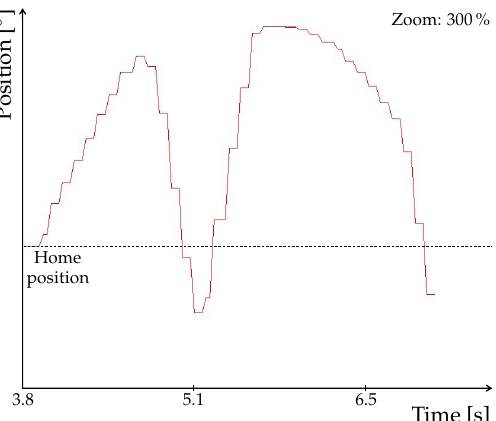
Figure 13. Detail of the signal obtained using PLC OPC UA server. adapter of one of the position axes. As shown in Figure 14a, the trace no longer contains 425 any apparent loops. Time profile of the signal depicted in Figure 14b is smoother, with 426 no abrupt changes, as shown in detail in Figure 15. 427